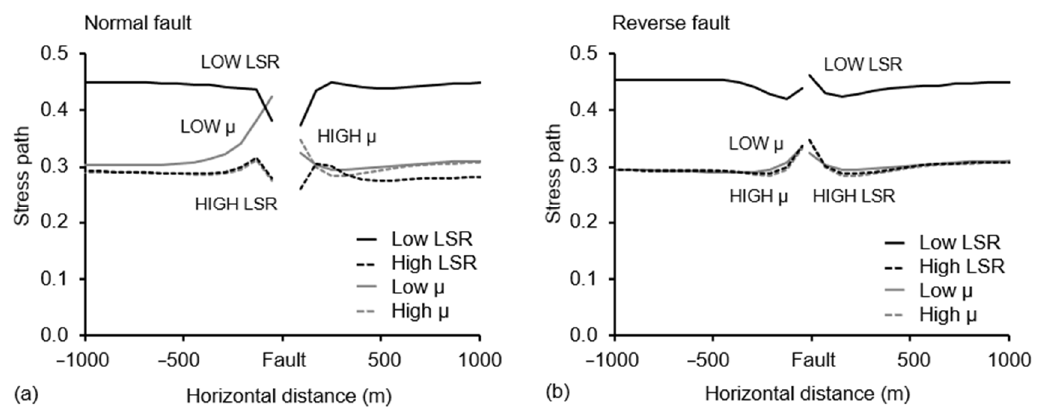
Figure 12. Stress path distribution along the x -axis at the reservoir middle line. ( a ) Normal fault and ( b ) reverse fault.